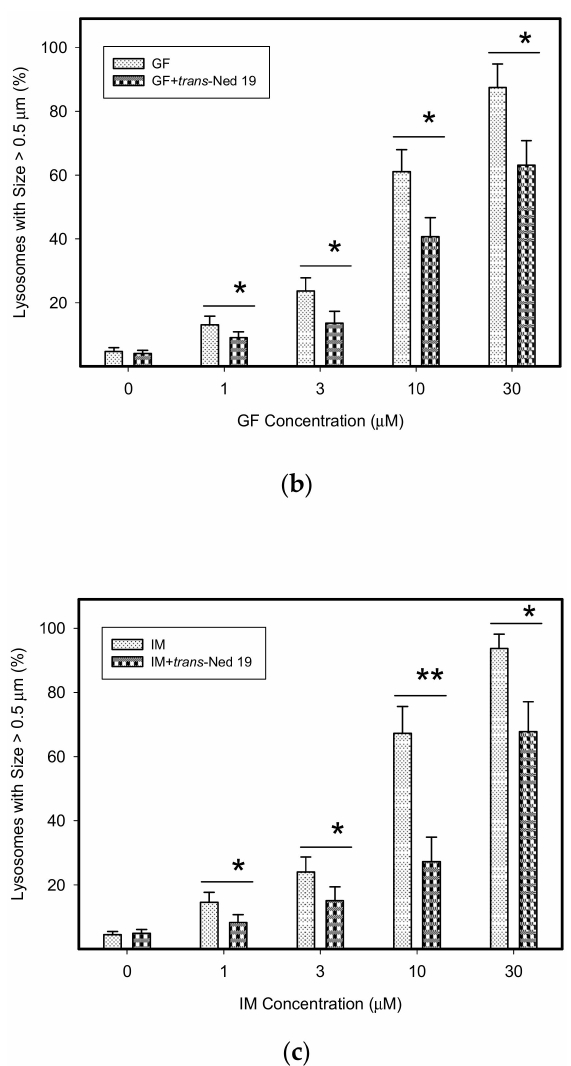
Figure 7. E ff ect of nicotinic acid adenine dinucleotide phosphate (NAADP) antagonist, trans -Ned 19, on lysosomal morphology in K562 cells treated with TKIs. Cells were cultured for 6 h in the presence of particular TKI with or without 10 µ M trans -Ned 19 under standard conditions and then fixed in paraformaldehyde and subjected to the immunostaining of LAMP1. Cells cultured in medium without TKIs were taken as a control. ( a ) Morphologic changes in lysosomes of K562 cells (typical analysis). ( b ) Quantitative analysis of lysosomal size in GF treated K562 cells. ( c ) Quantitative analysis of lysosomal size in IM treated K562 cells. Lysosomal morphology was evaluated in at least 250 cells for each treatment. The results are represented as means of four independent experiments with standard deviations. * denotes significant change in the number of lysosomes with size > 0.5 µ m ( p < 0.05) between cells treated with TKI and cells treated with TKI + trans -Ned 19. ** denotes significant change in the number of lysosomes with size > 0.5 µ m ( p < 0.01) between cells treated with TKI and cells treated with TKI + trans -Ned